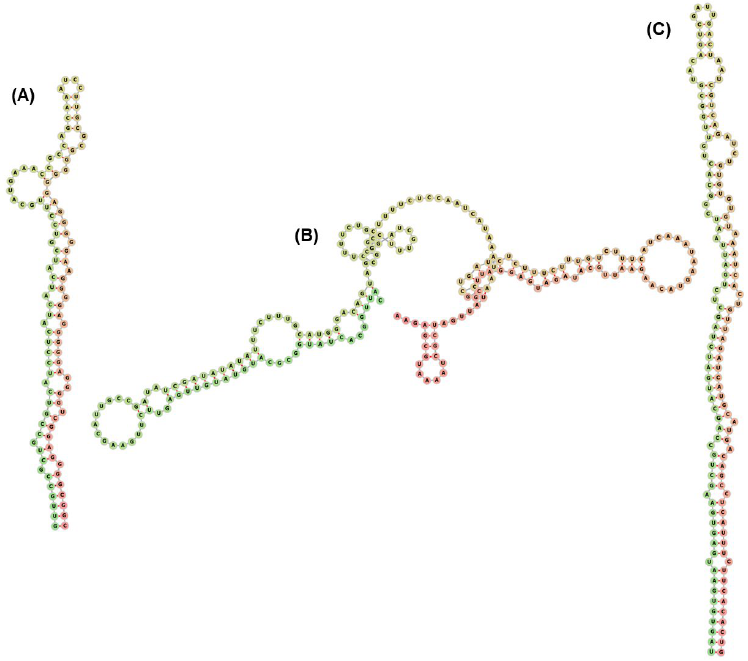
Figure 6. The RNAfold web server predicted the folding structure of the precursor osa-miR414 ( A ), osa-miR5505 ( B ), and osa-miR167a-3p ( C ).